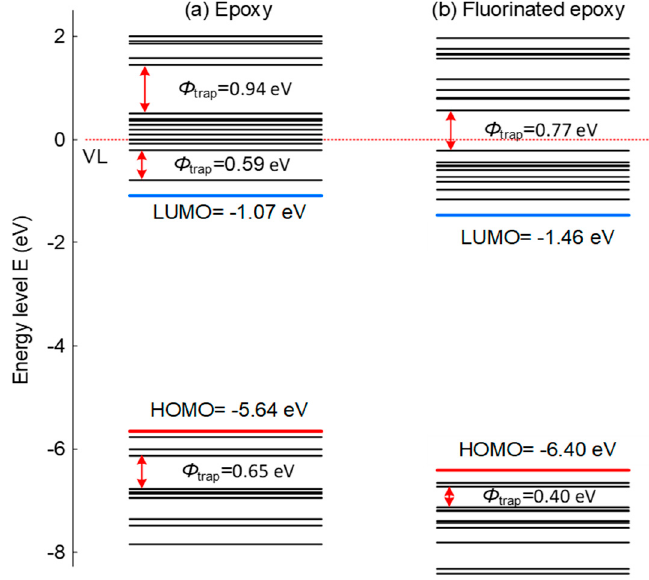
Figure 1. Surface potential decay process and trap distribution of epoxy resin before and after fluorination. ( a ) Relationship between the decay time and the surface charge density; ( b ) relationship between the energy level and the trap density of epoxy samples.